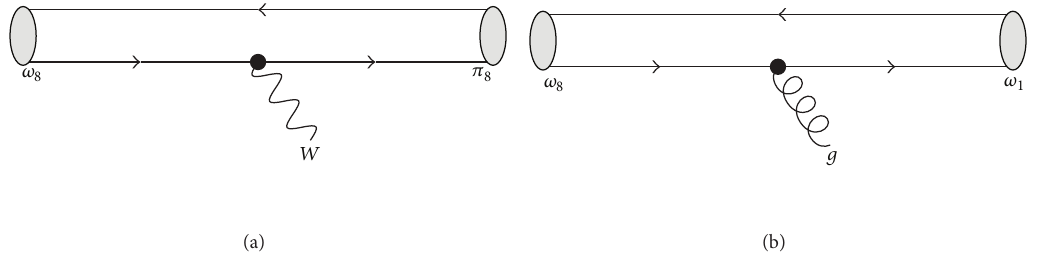
Figure 9: Meson transition currents for 𝜔 8 → 𝜋 8 and 𝜔 8 → 𝜔 1